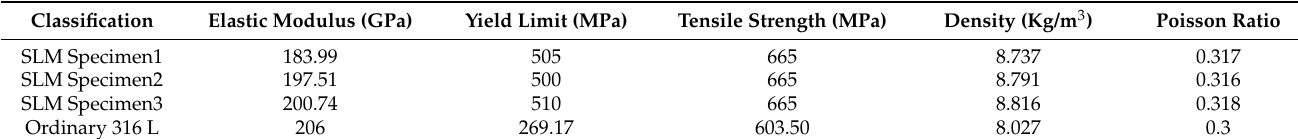
Table 3. Comparison of main parameters of SLM process and ordinary 316 L.